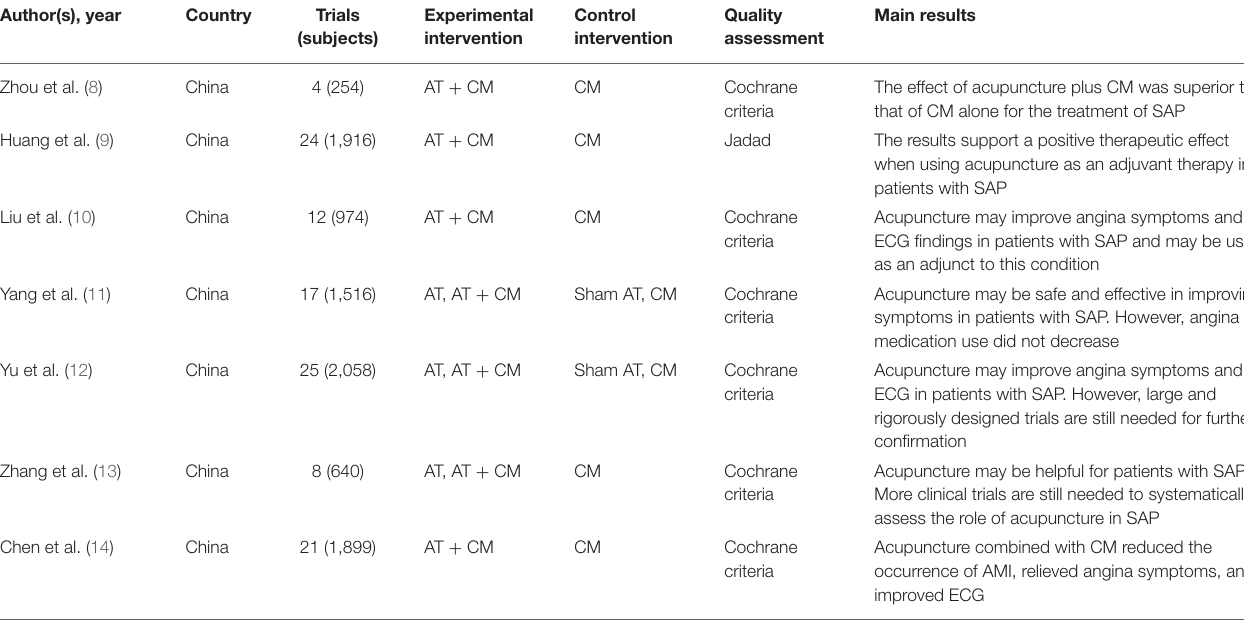
TABLE 2 | Characteristics of the studies.